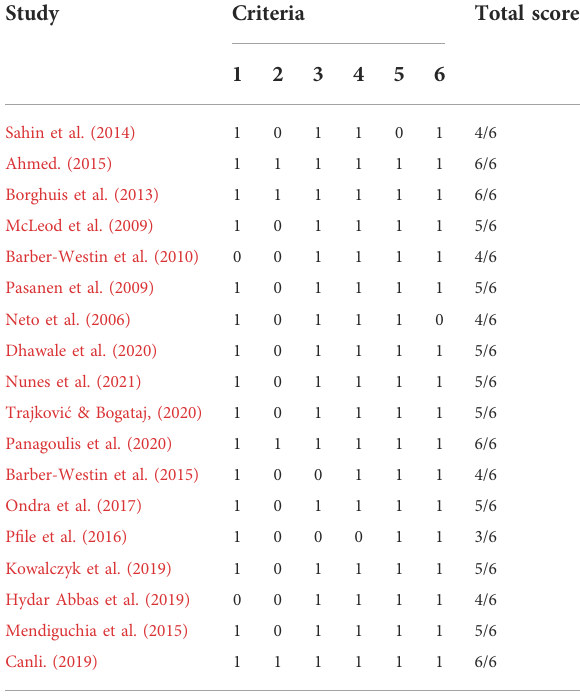
TABLE 1 Risk of bias assessment of the included